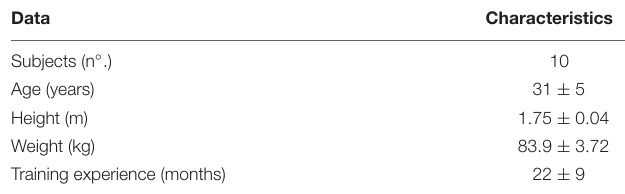
TABLE 1 | Descriptive data of the sample.